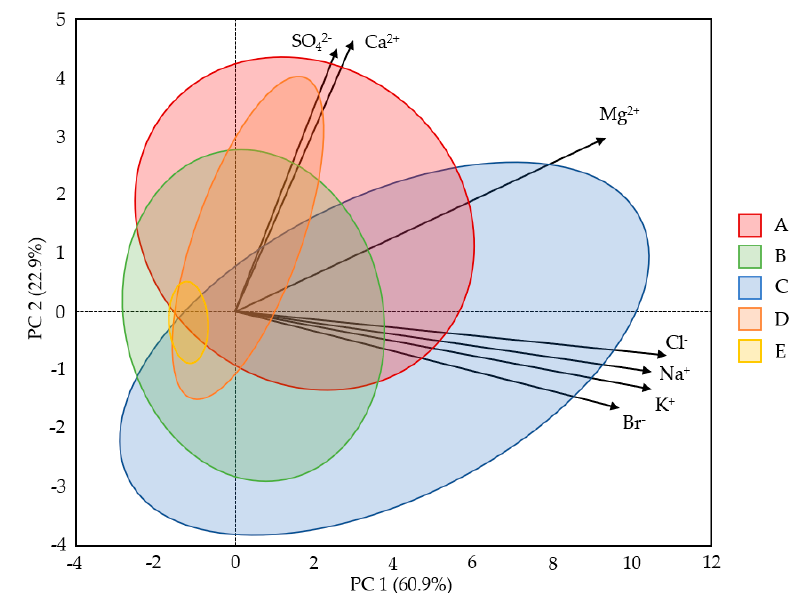
Figure 7. Biplot showing the principal component analysis (PCA) score plot overlaid with the loading plot for principal component 1 (PC 1) and principal component 2 (PC 2). Each ellipse shows where 95% of data of each station are expected to lie.